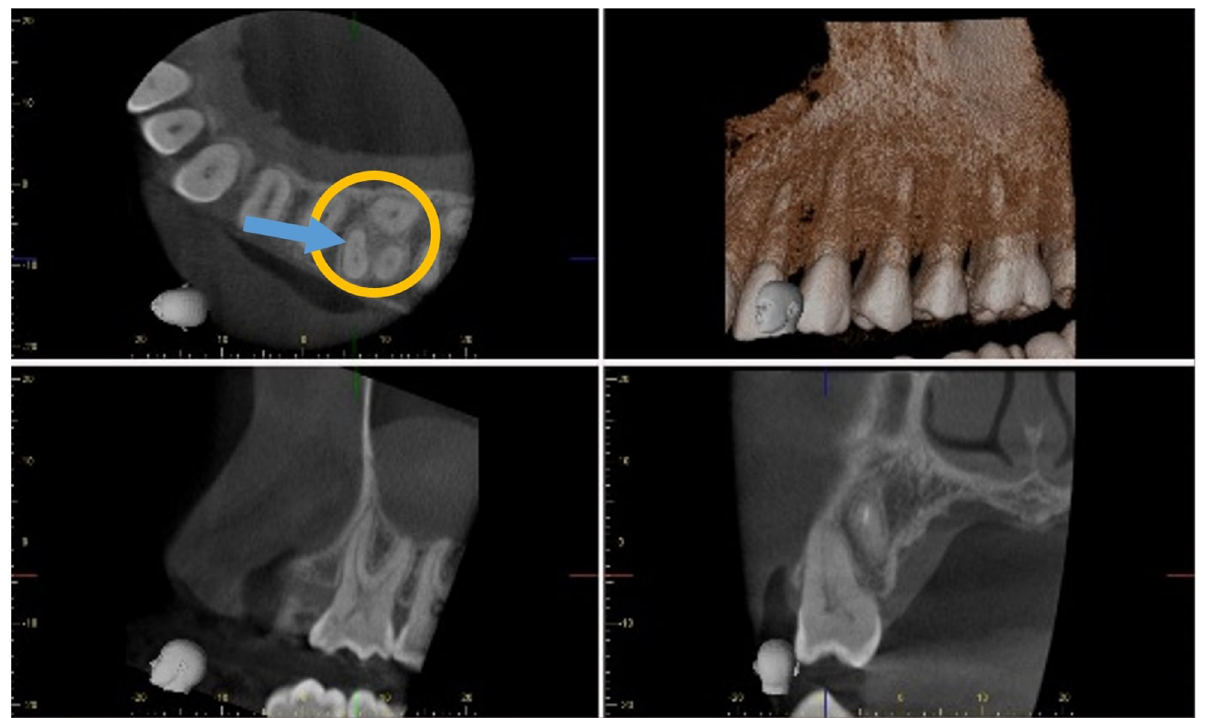
Fig. 3 CBCT scan of teeth in the upper left maxillary region. A distinct MB-2 canal (blue arrow) on an axial cross section of an upper fi rst molar (yellow